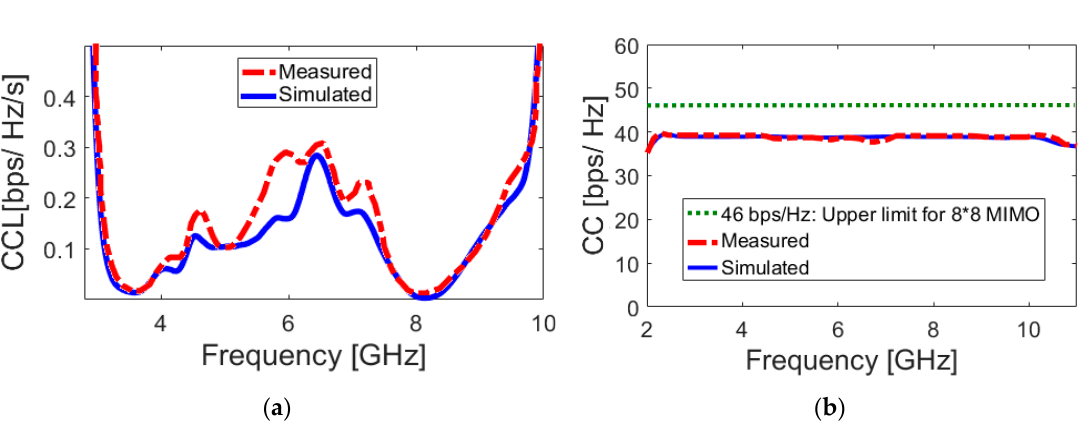
Figure 24. Calculated ( a ) channel capacity loss (CCL) and ( b ) channel capacity (CC) of the smartphone antenna.